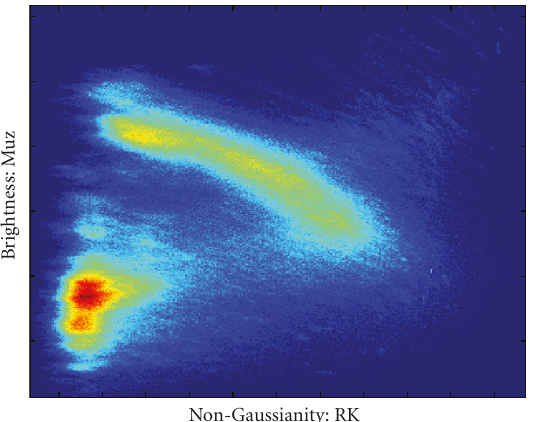
Figure 9: Two-feature scatter plot: non-Gaussianity versus Bright- ness. Note the natural clusters, but remember that there are four other dimensions too.